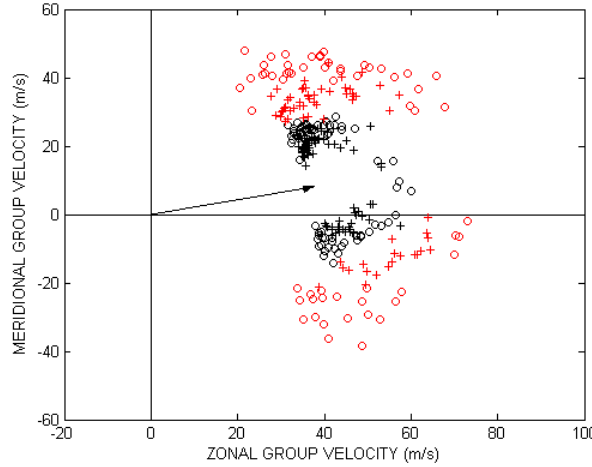
Fig. 15. Scattering plots of the virtual horizontal group velocities Fig. 15 Scattering plots of the virtual horizontal group velocities of the upward of the upward gravity wave packets of the winter data. Wave pack- gravity wave packets of the winter data. Wave packets obtained by windows ets obtained by windows T3aZ4, T3bZ4 and T3cZ4 were denoted T3aZ4, T3bZ4 and T3cZ4 were denoted by ‘cross’ ; wave packets obtained by by cross; wave packets obtained by windows T3aZ5, T3bZ5 and T3cZ5 were denoted by open circle. Red colour symbols represent windows T3aZ5, T3bZ5 and T3cZ5 were denoted by ‘open circle’ . Red color the model with VB-period of 5min, and black colour symbols rep- represents the model with VB-period of 5 min, and black color represents the resent the model of VB-period of 10min. model of VB-period of 10 min.